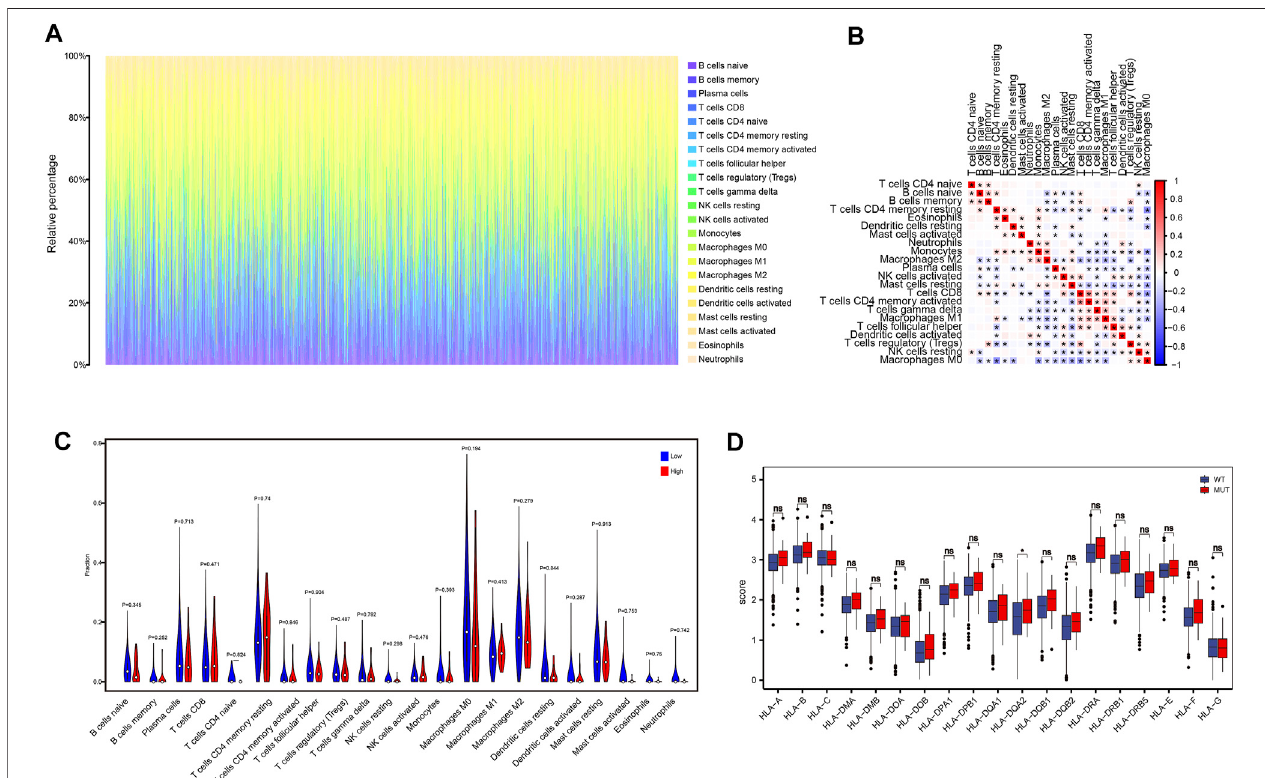
FIGURE 7 | Effect ofMDN1 gene mutation on immune cell in fi ltration in TCGA-BRCA dataset. (A) Panorama ofimmune cell in fi ltration in TCGA-BRCA dataset; (B) Correlation analysis of 22 immune cell types in TCGA-BRCA dataset; (C) Multiple immune cell in fi ltration levels do not differ signi fi cantly between different mutation groups of MDN1 gene in TCGA-BRCA patients; (D) HLA family genes are signi fi cantly different between the MDN1 mutation group and MDN1 wild-type group.